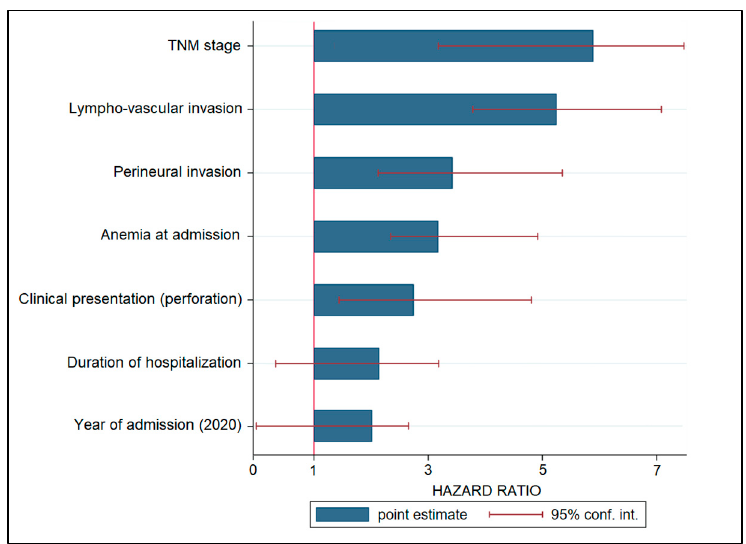
Figure 3. Risk factor analysis for disease progression in patients with colorectal cancer.